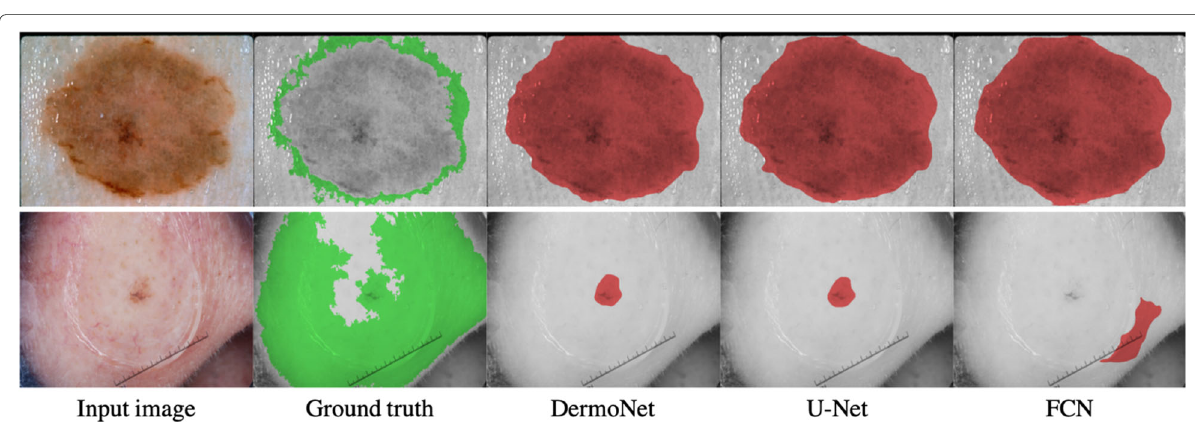
Fig. 5 Cases where our proposed DermoNet outperforms FCN and U-Net